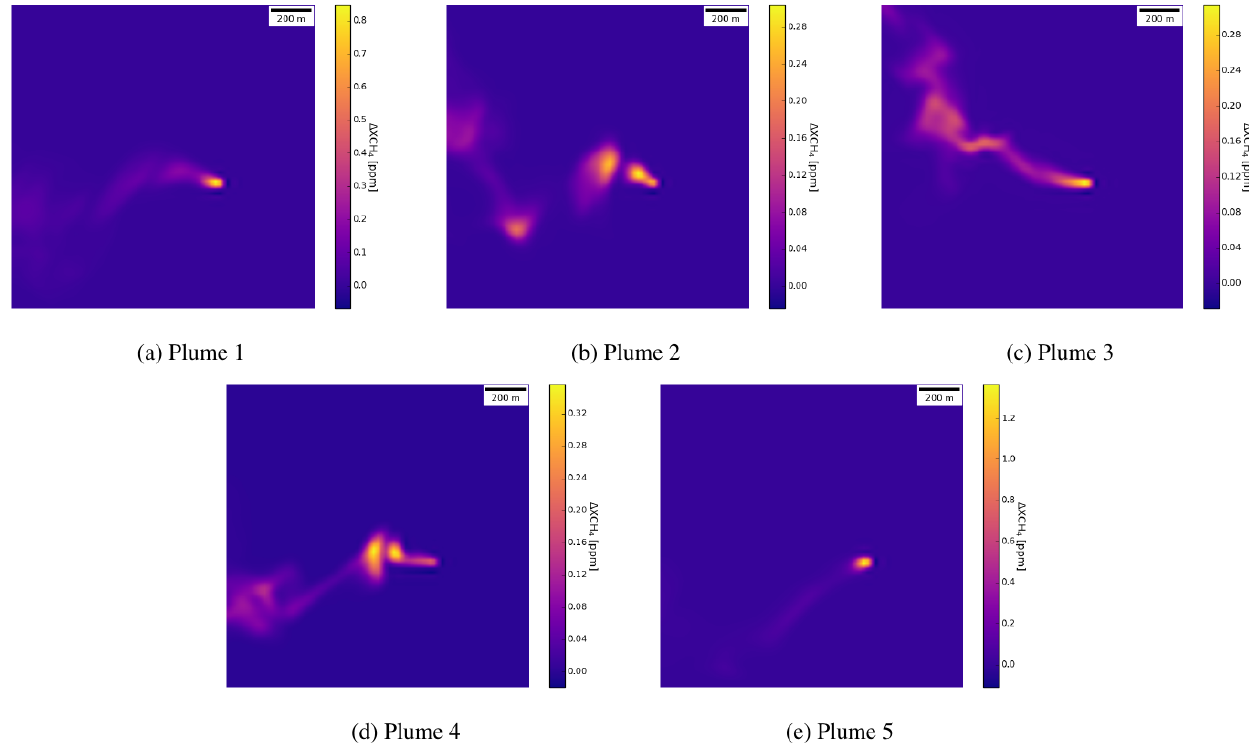
Figure 3. Methane enhancement map (cid:49)X CH resampling to 20m